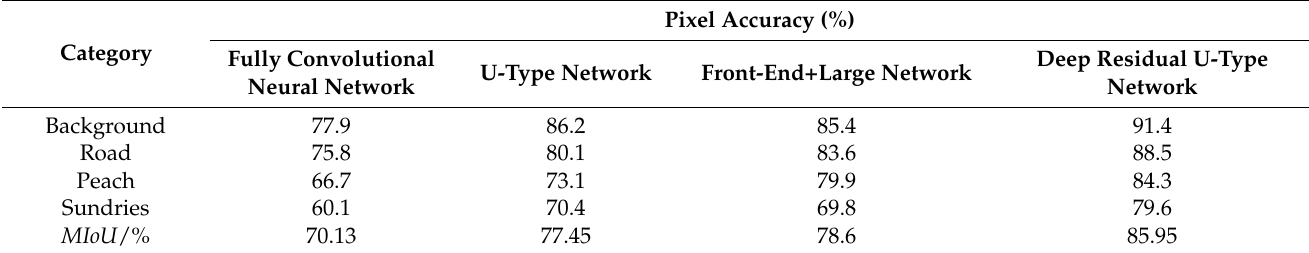
Figure 8. The iteration loss and MIoU of the deep residual U-type network. Table 2. Semantic segmentation results of different network models.